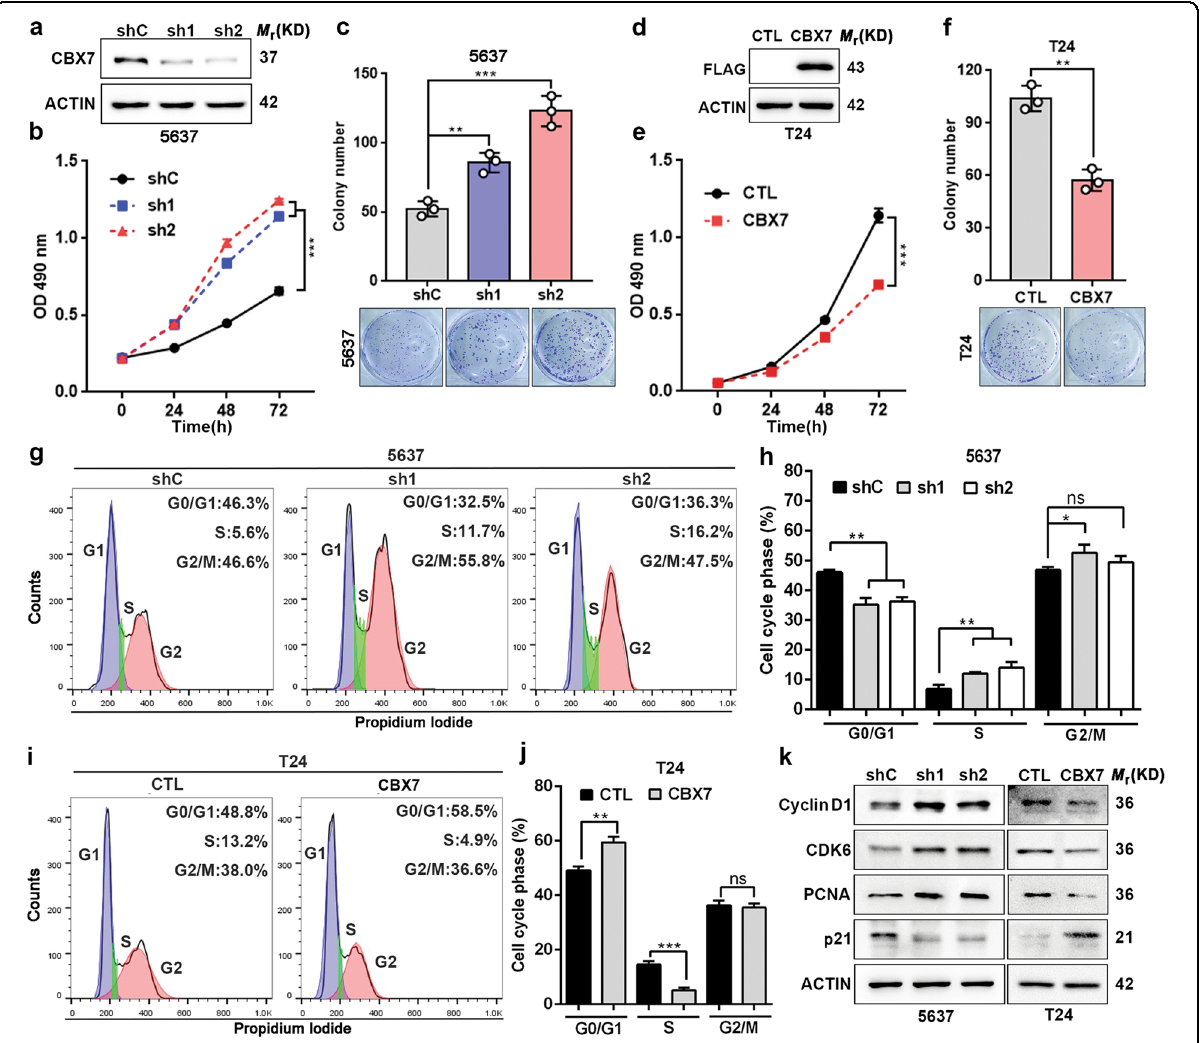
Fig. 2 CBX7 inhibits UBC cells proliferation through the induction of cell cycle arrest. a Knockdown of CBX7 in 5637 cell was con fi rmed by western blotting. b , c Effects of CBX7 knockdown on cell viability and colony formation d Ectopic expression of CBX7 in T24 cell was con fi rmed by western blotting. e , f Effects of CBX7 overexpression on cell viability and colony formation. g – j Effects of CBX7 on cell cycle were determined by fl ow cytometry analysis. k Certain cell cycle-related regulators were analyzed by western blotting. Data are presented as means ± SD from three independent replicates. * p < 0.05, ** p < 0.01, *** p < 0.001, ns nonsigni fi